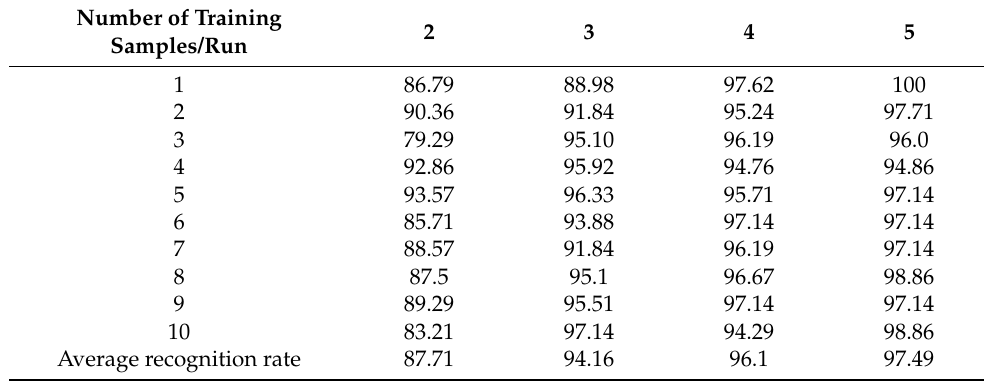
Table 2. Ten experiments with RLD (ORL face database (%)).